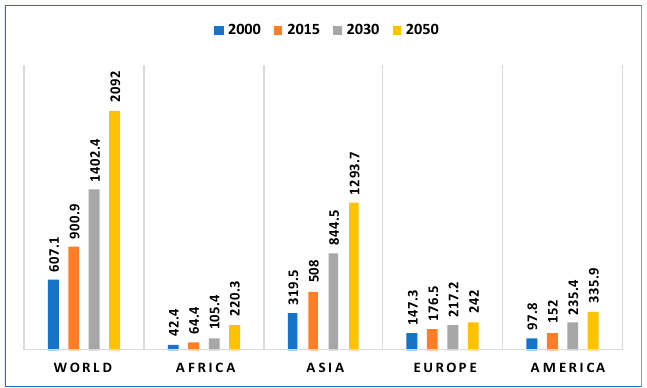
Figure 2. Numbers of persons (millions) aged over 60 years in the world in different years [1].